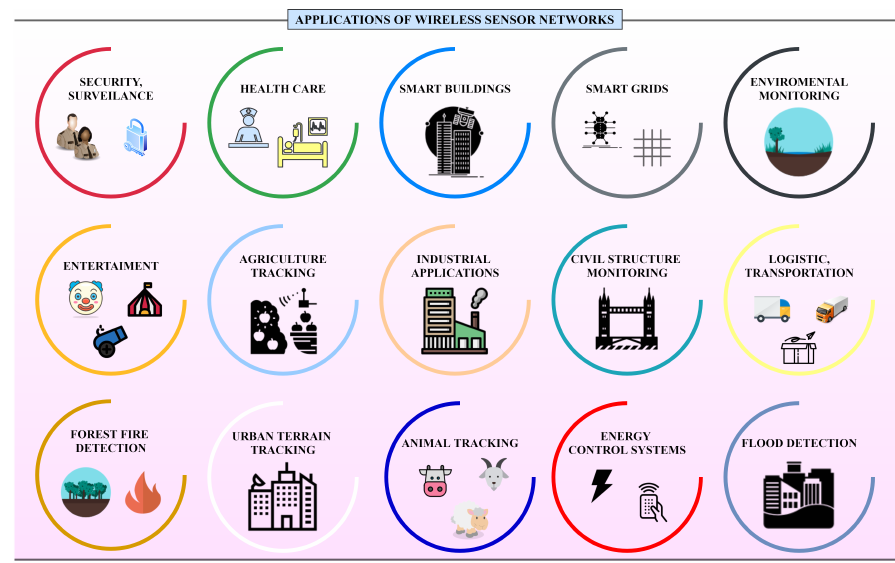
Figure 3. List of common applications of wireless sensor networks.